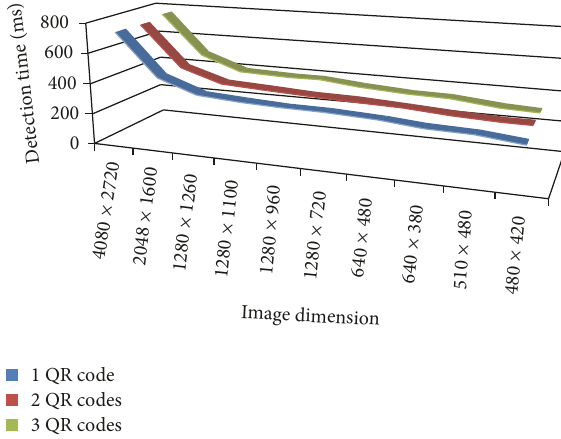
Figure 11: Required time for detection of single or multiple QR symbols in images with different dimensions.